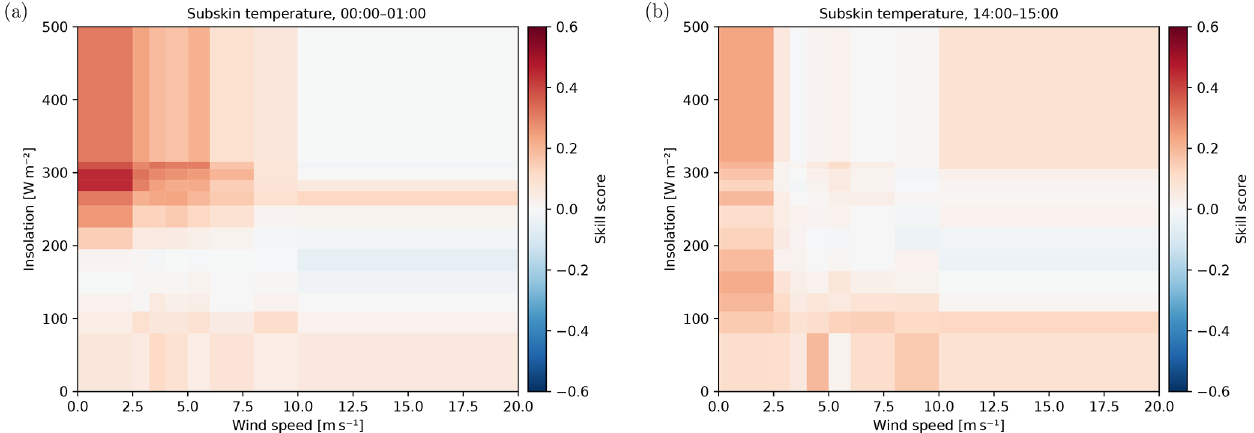
Figure 4. Skill score of the CCA OO compared to the OGCM upper layer for all wind and insolation categories at midnight (a) and in the afternoon (b)